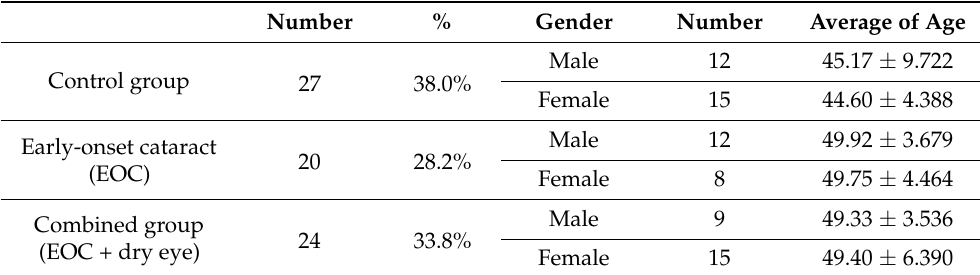
Table 1. Patient gender and age characteristics for each experimental group.